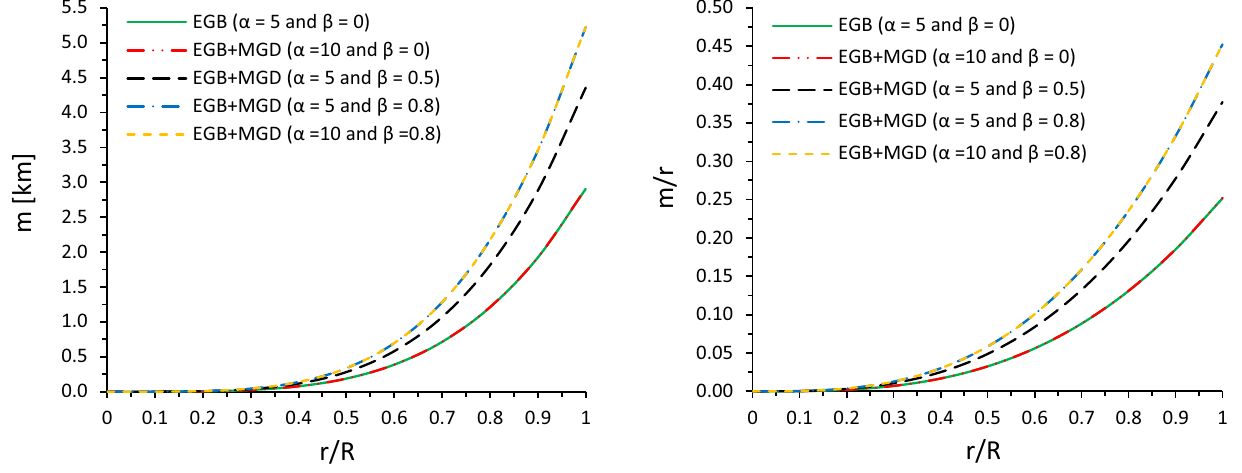
Fig. 6 The variation of mass function m ( r ) and mass-radius ratio ( m / r ) versus radial coordinate r / R